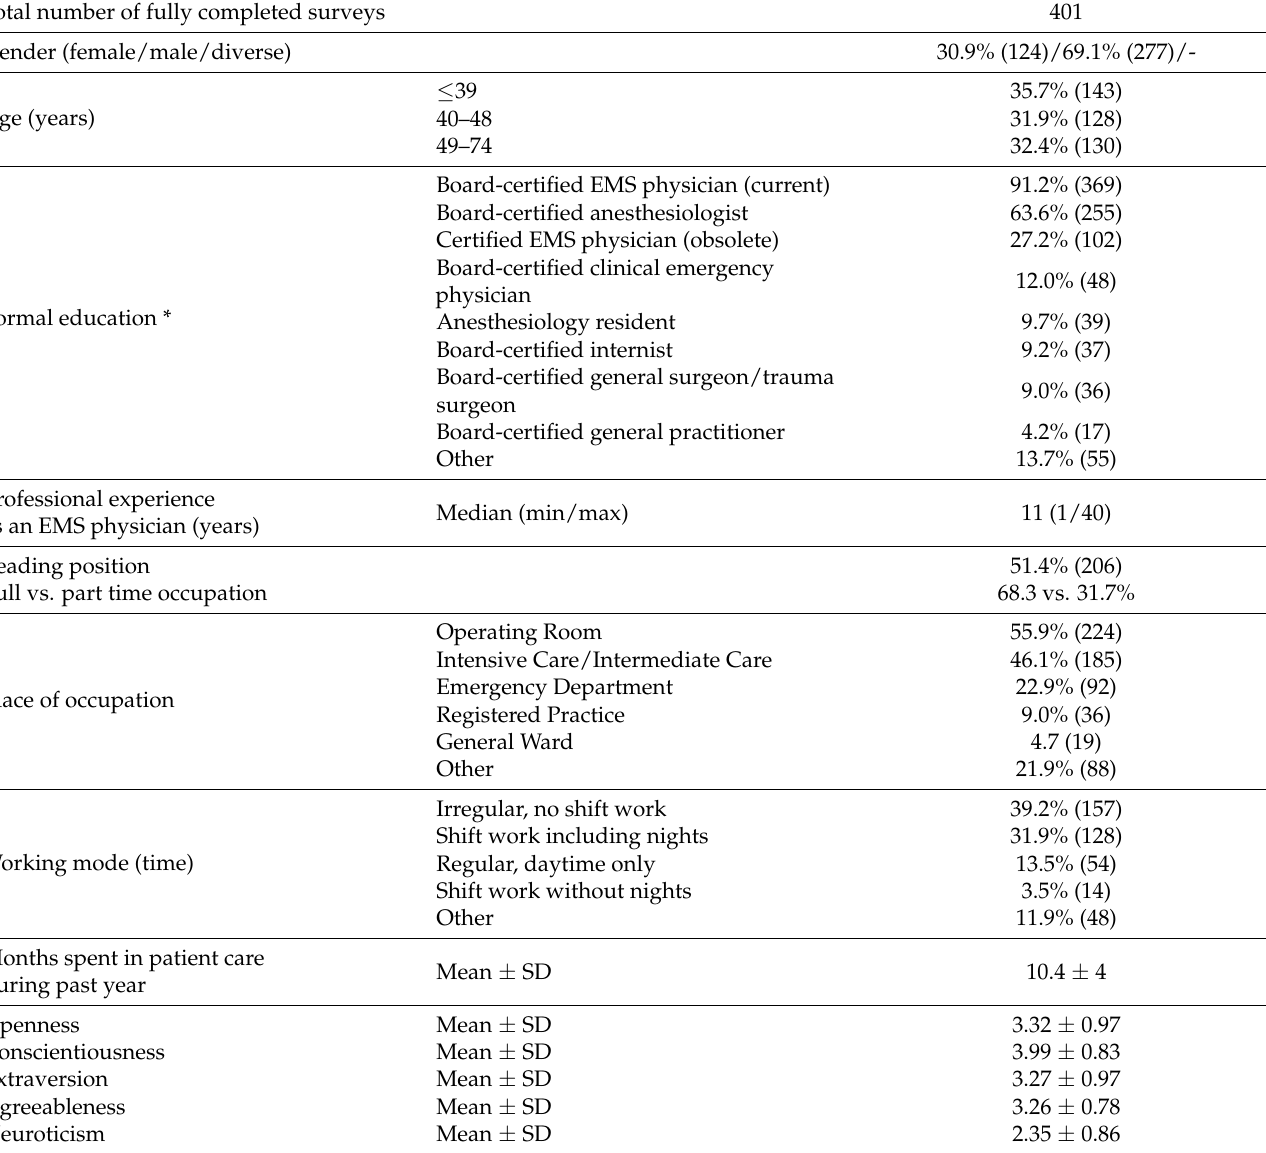
Table 1. Baseline